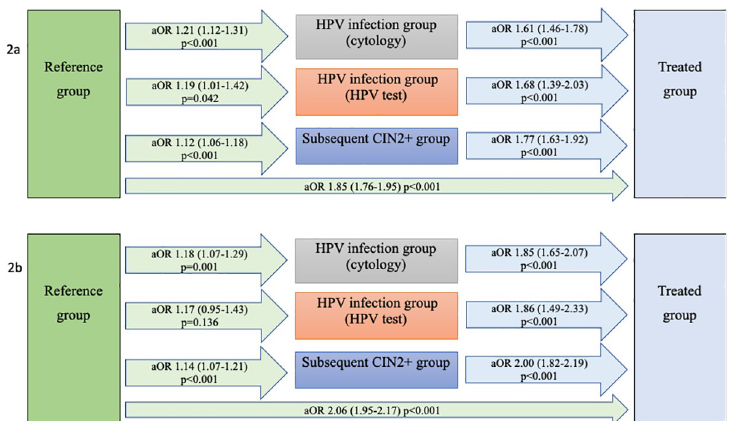
Fig 2. Risk of preterm delivery and spontaneous preterm delivery—adjusted logistic regression. Preterm delivery (2a); spontaneous preterm delivery (2b). Women with HPV infection had an increased risk of preterm delivery and spontaneous preterm delivery; treatment increased the risk further. aORs are given, with 95% confidence intervals in parentheses. Analyses adjusted for year of delivery, maternal age, parity, BMI, marital status, country of birth, infant’s sex, smoking, income, education level, and assisted reproduction. aOR, adjusted odds ratio; CIN, cervical intraepithelial neoplasia; HPV, human papillomavirus.